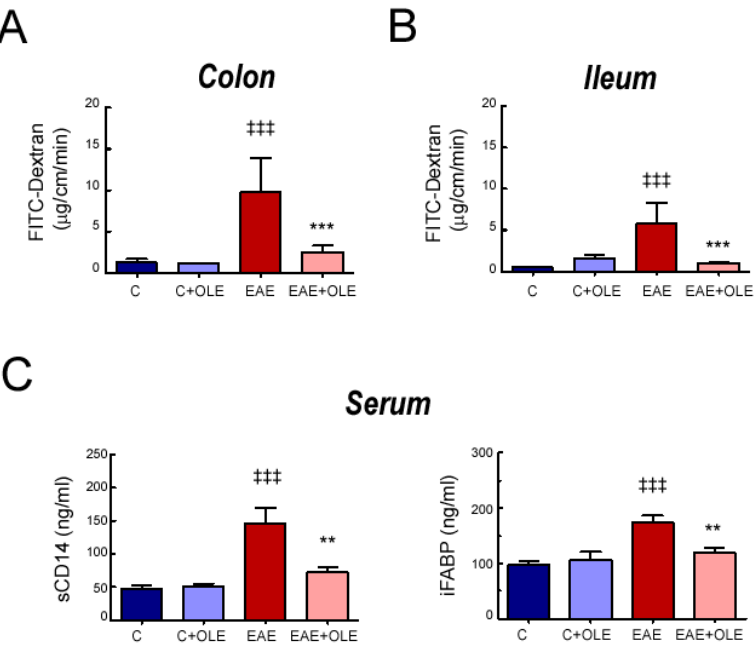
Figure 2. OLE treatment protects from intestinal permeability in EAE mice. Intestinal sacs pre- pared from colon ( A ) and Ileum ( B ) to assess intestinal permeability. Sacs were loaded with FITC- labeled Dextran (FD-40) and placed in a bath. After 120 min, the FD-40 concentration from the bath solutions was quantified. ( C ) Levels of soluble CD14 and iFABP in serum, quantified by ELISA. Results were expressed as the mean ± SEM, n = 5–7 per group. ‡‡‡ p < 0.001 vs. control; and ** p < 0.01 and *** p < 0.001 vs. untreated-EAE. C, healthy mice. C + OLE, healthy mice treated with OLE. EAE, induced mice. EAE + OLE, induced mice treated with OLE.